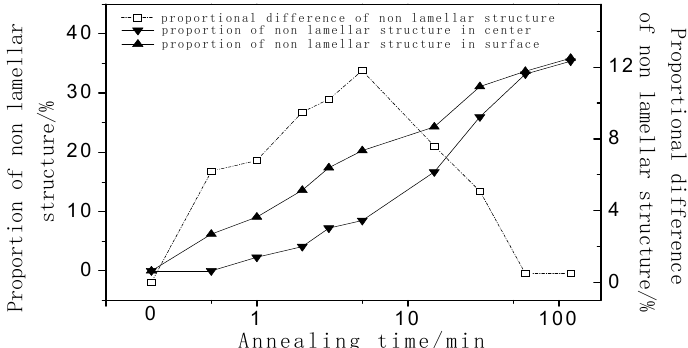
Figure 6. Proportion of non-lamellar structure on the surface and in the center of each specimen.